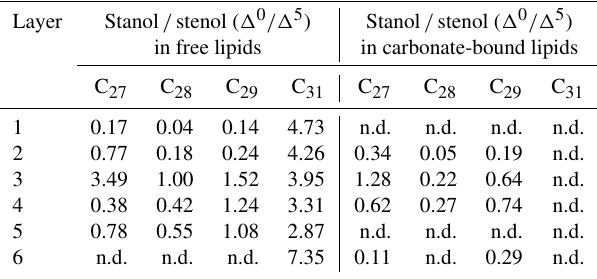
layers (3–6), however, the carbonate-bound and freely ex- tractable sterols were of the same order ( ∼ 10 − 2 µg g − 1 dry mat range). C 27 –C 29 sterenes were also detected in both lipid pools, but only at trace abundances.